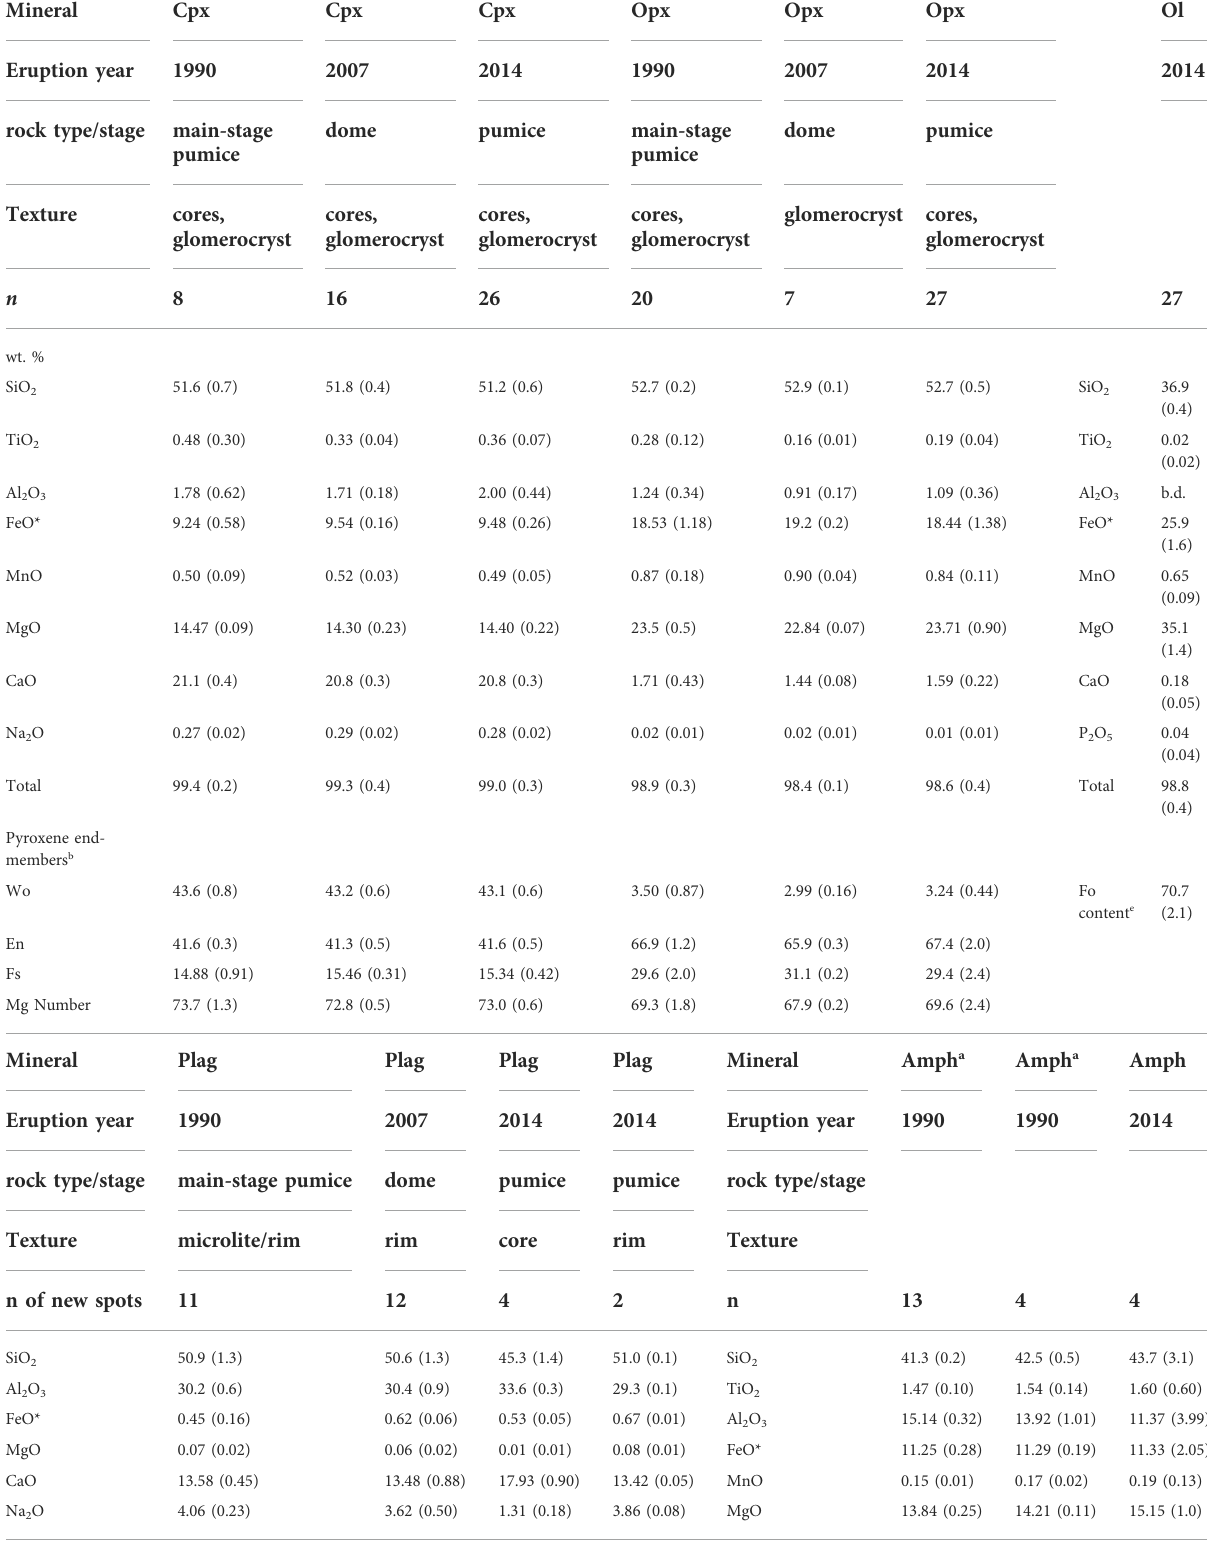
TABLE 3 Summary of representative mineral compositions from the 1990 – 2014 eruptions.